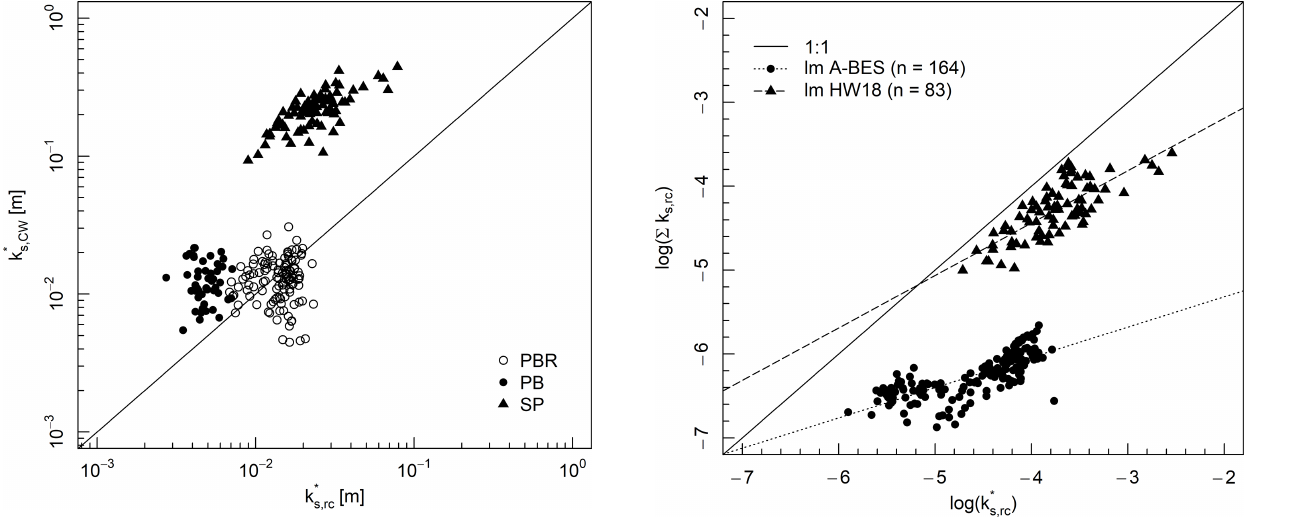
Figure 5. Relationship between k ∗ s, rc and (cid:54)k s, rc for the A-BES and Hohermuth and Weitbrecht (2018)